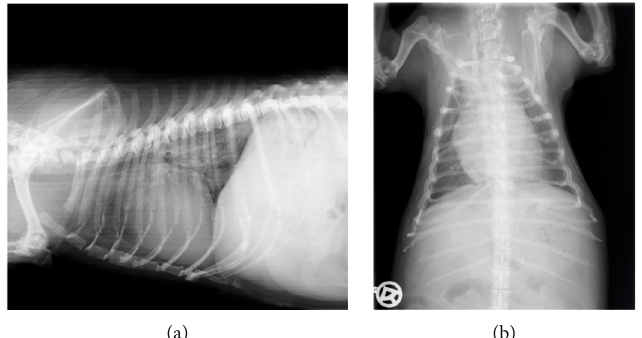
Figure 1: Chest X-ray in 2 planes showing cardiomegaly with left atrial enlargement (VHS 11) and mixed bronchoalveolar lung markings perihilar and in the caudodorsal lung fi